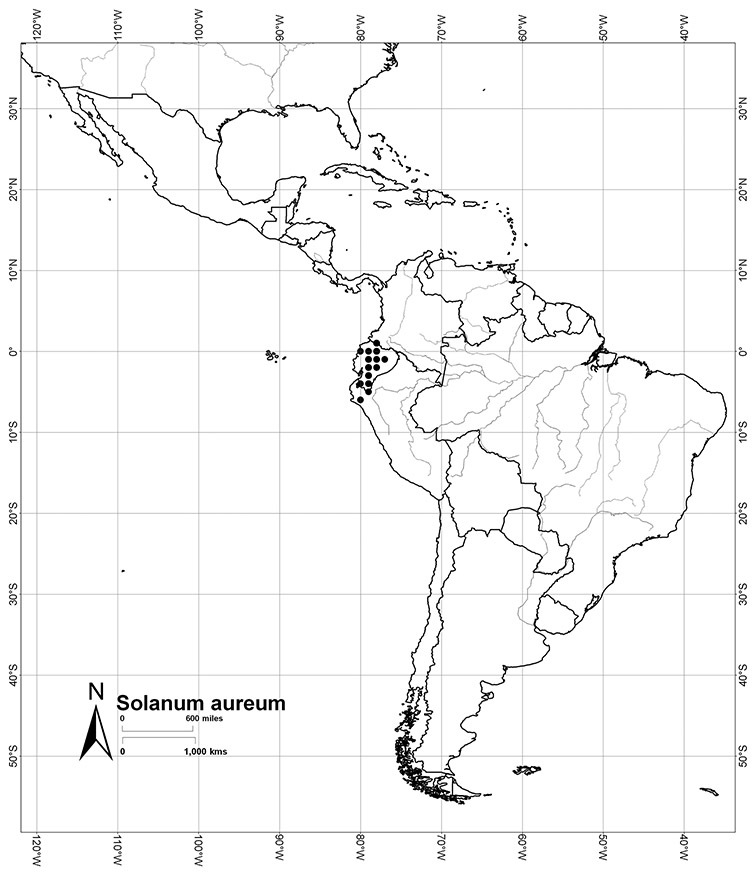
Distribution of Solanum aureum Dunal.